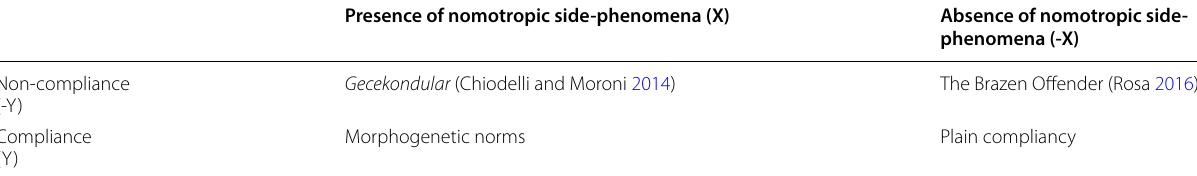
Table 1 Different kinds of nomotropism in architecture Presence of nomotropic side-phenomena (X) Absence of nomotropic side-